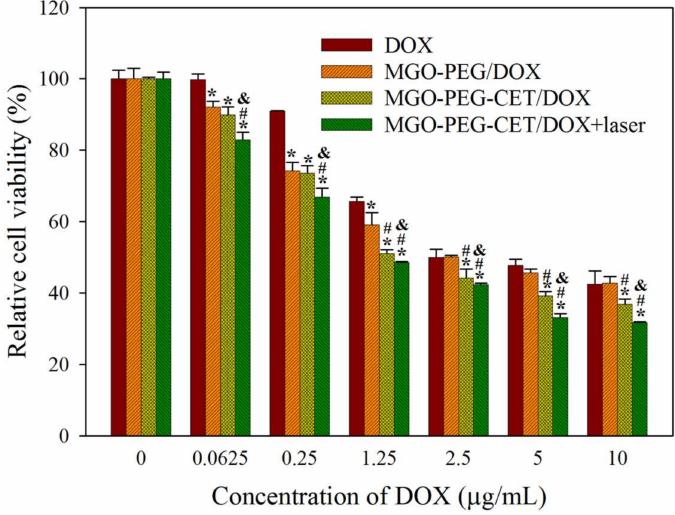
Figure 9. In vitro cytotoxicity of DOX, MGO-PEG/DOX, MGO-PEG-CET/DOX and MGO-PEG-CET/DOX + laser after contacted with CT-26 cells for 24 h. The laser group was subject to 2.5 W/cm 2 NIR light exposure for 3 min after treating with MGO-PEG-CET/DOX. * p < 0.05 compared with DOX. # p < 0.05 compared with MGO-PEG/DOX. & p < 0.05 as compared with